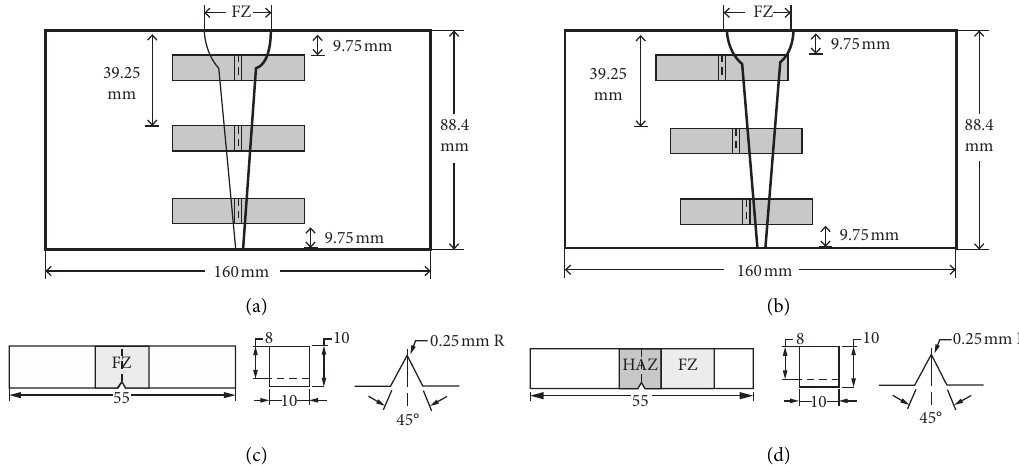
Figure 4: Charpy samples extracted with the V-notch root in (a) the FZ and (b) the HAZ with the corresponding geometry of the (c) FZ and (d) HAZ Charpy samples (units are in